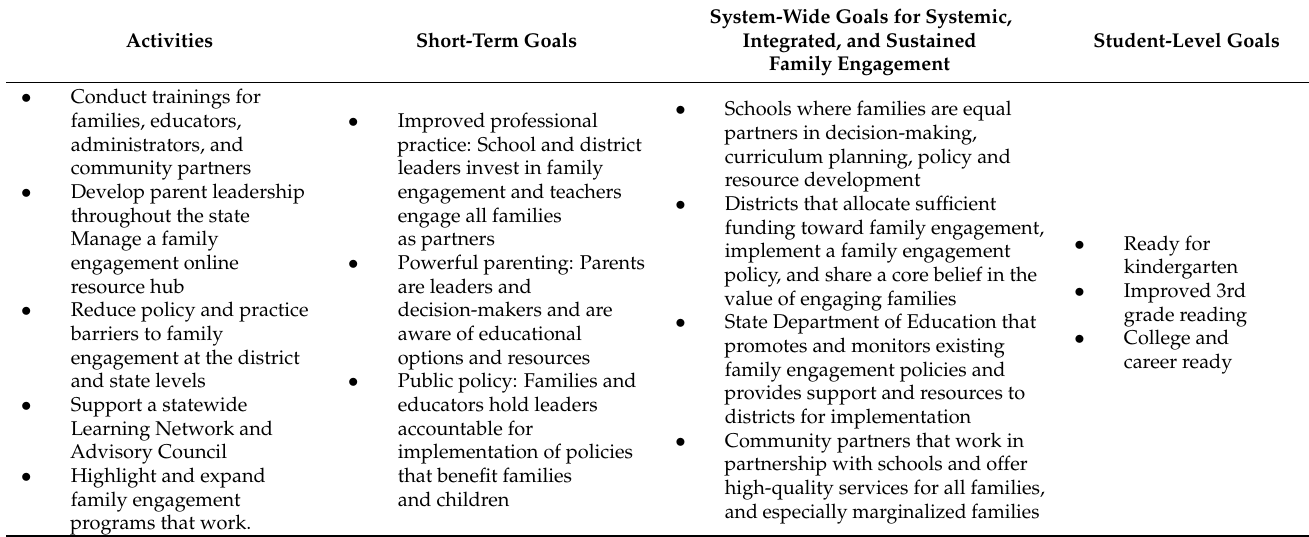
Table 1. KY Collaborative Activities, Short-Term Goals, and Systemic Goals.